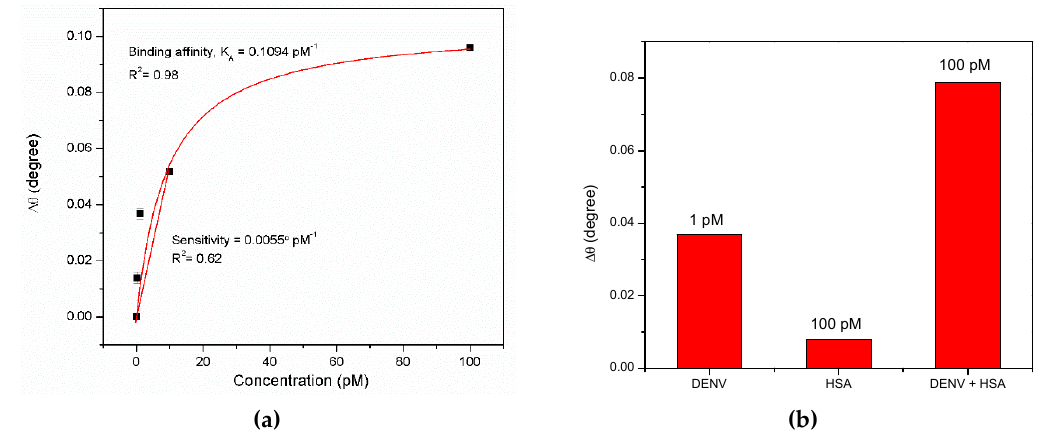
Figure5. OpticalreflectanceforDENVconcentrations(0.1–100pM)incontactwithAu / CdSQDs-rGO / Ab Figure 5. Optical reflectance for DENV concentrations (0.1–100 pM) in contact with Au/CdSQDs- layer (inset: the zoomed in graph). rGO/Ab layer (inset: the zoomed in graph).